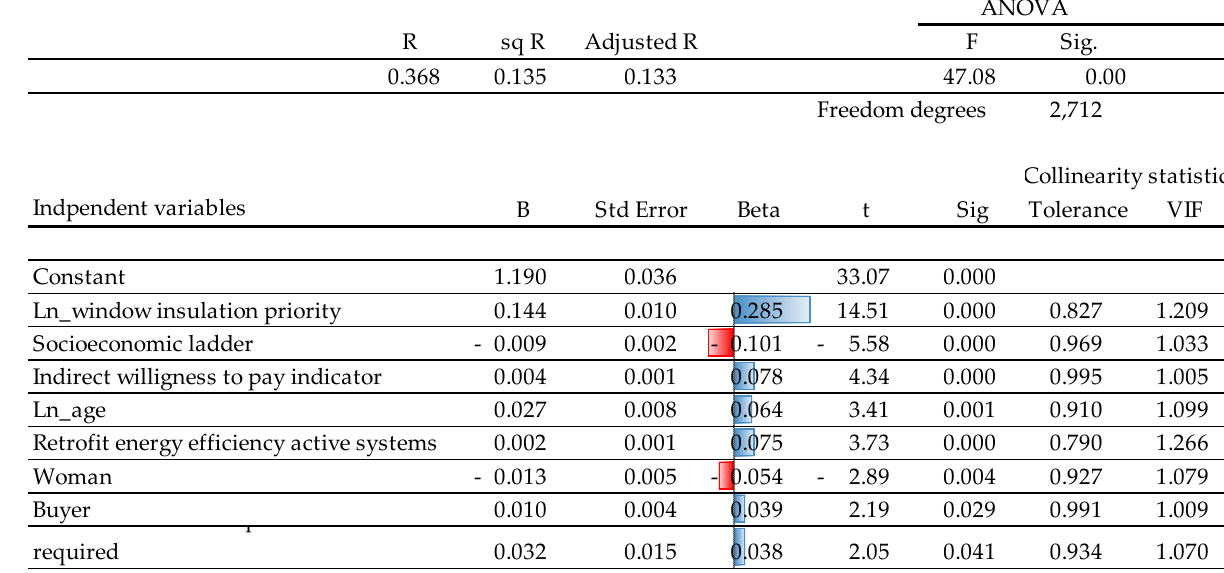
Figure 7. Regression model to identify the factors influencing the perception of EE benefits. Source: Self elaboration.